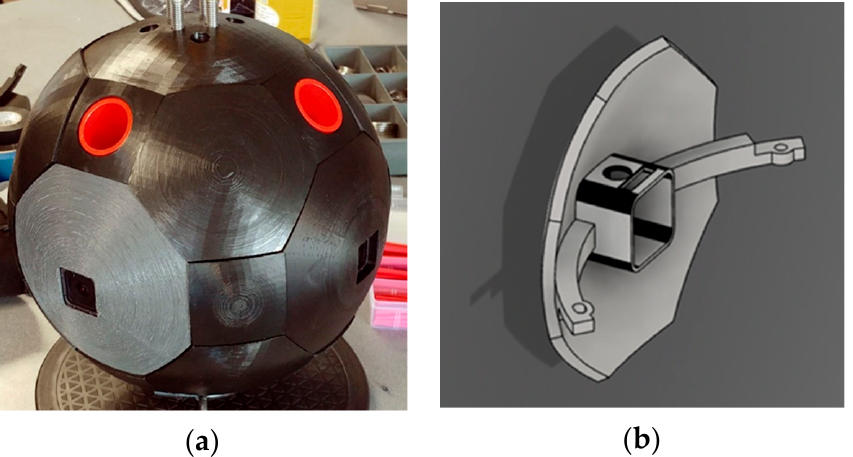
Figure 12. Camera payload configuration ( a ) Equatorial ring modified to carry four GoPro Hero